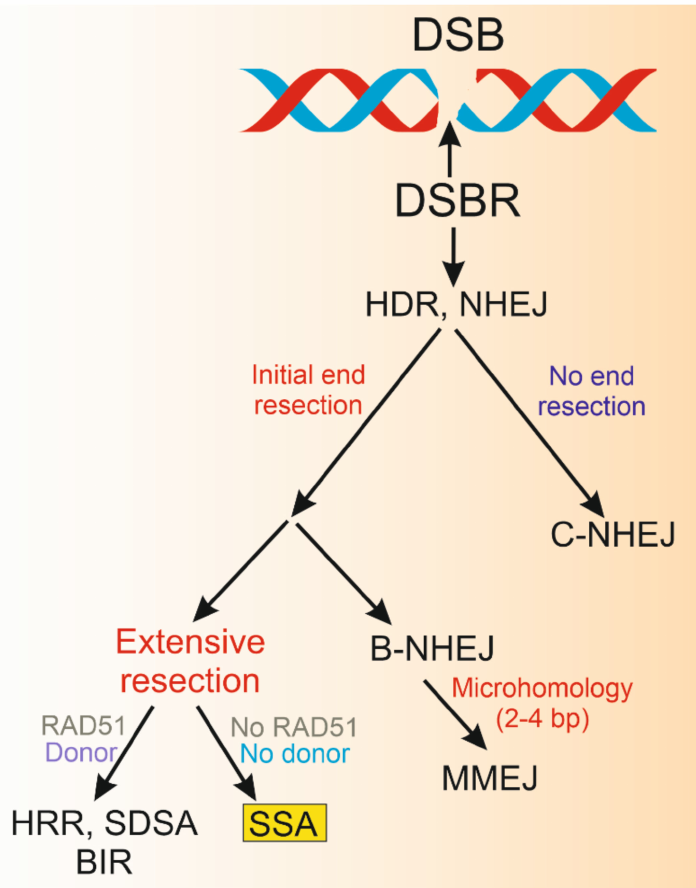
Figure 1. Single-strand annealing (SSA) is a DNA double-strand break (DSB) repair (DSBR) system which uses homologous repeats flanking a DSB. Therefore, SSA is a pathway in the homology-directed repair (HDR), which includes homologous recombination repair (HRR), synthesis-dependent strand annealing (SDSA), and break-induced recombination (BIR). The other group of DSBR pathways, non-homologous end joining (NHEJ), in its canonical form (C-NHEJ) is independent of homology, but its backup variant (B-NHEJ) uses microhomology (2-4 bp), taking the form of microhomology- mediated end joining (MMEJ). HDR and MMEJ, in contrary to C-NHEJ, require DNA end resection to expose 3 (cid:48) single-stranded DNA fragments. These fragments may undergo further, extensive resection and invade double-stranded DNA (Donor), which provides a template DNA as in HRR, SDSA, and BIR when active RAD51 (RAD51 Double Strand Break Repair Protein) is present. When there is no active RAD51 or, despite its presence, no donor DNA, 3 (cid:48) ss overhangs produced in the end resection process may be a substrate for SSA. After initial resection B-NHEJ may occur, especially when short homologous sequences are located near the DSB